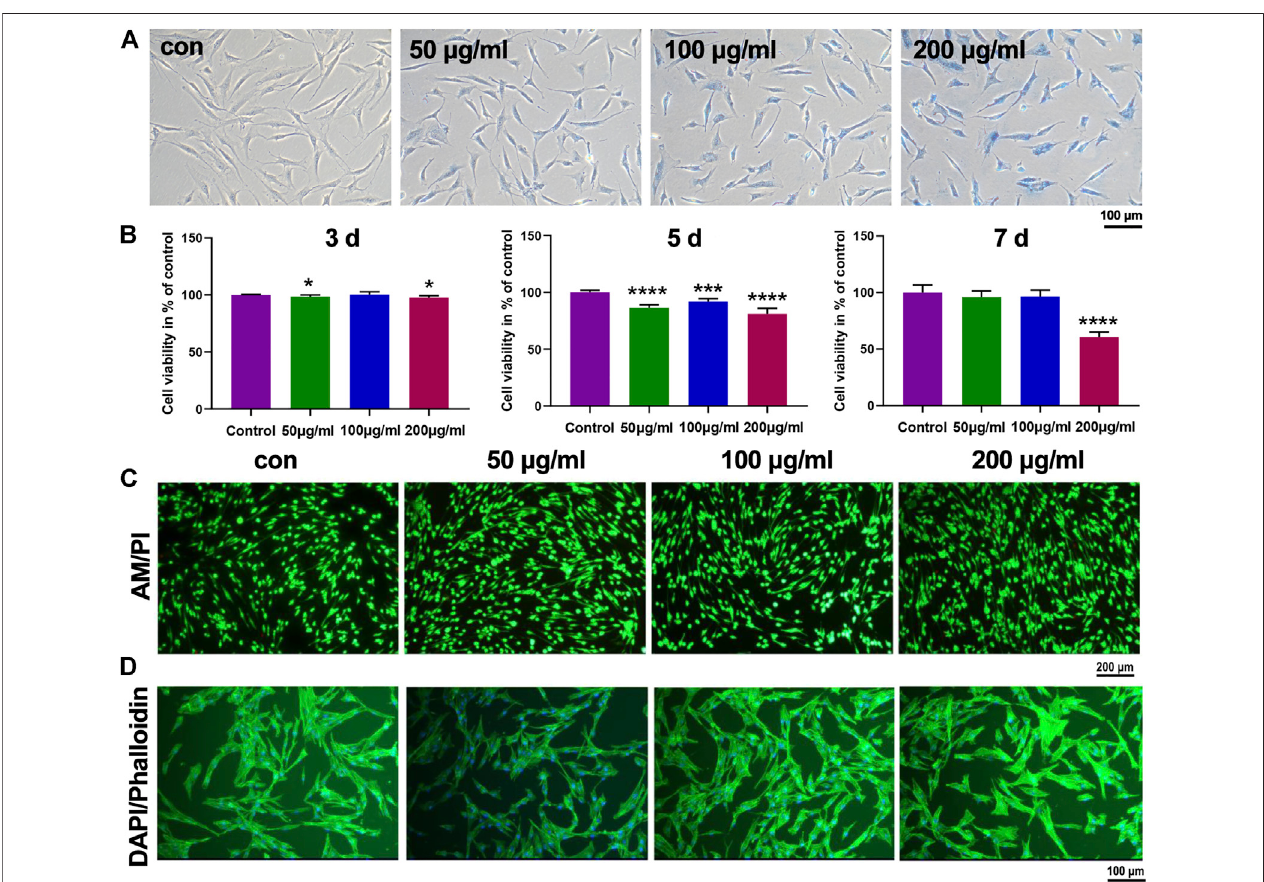
FIGURE 3 | In vitro biocompatibility and cellular uptake of IONPs on PCSCs. (A) Prussian blue staining of PCSCs treated with IONPs with various concentrations (50, 100, and 200 μ g/ml). (B) CellviabilityofPCSCs after incubated with IONPs (concentration: 50,100,and 200 μ g/ml)for 3,5,and 7 days.Representativescanof (C) live/dead staining (green- and red-labeled cells denote living and dead cells, respectively) and (D) cytoskeleton staining of PCSCs after treated with IONPs with various concentration (50, 100, and 200 μ g/ml), respectively. Asterisk indicates statistically signi fi cant differences between the control and experience groups ( p p < 0.05; ppp p < 0.005; and pppp p <